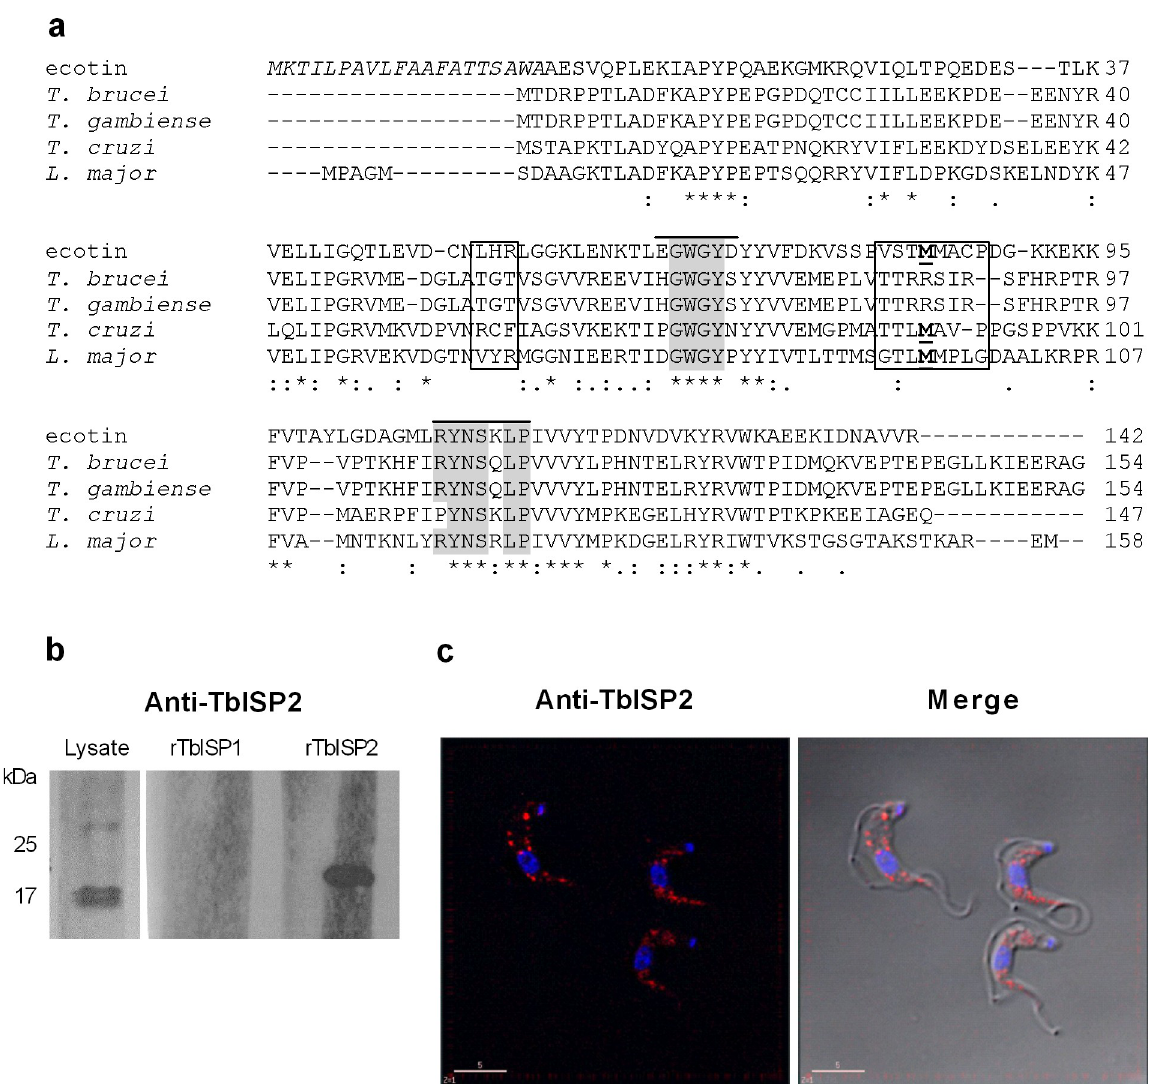
Fig 1. Expression of TbISP2 by T . b . rhodesiense bloodstream forms. (a) Alignment of predicted amino acid sequences of ecotin and ISP2. The numbering for ecotin indicates the mature protein, which starts at Ala1, and the signal peptide prior to this is given in italics. The primary enzyme recognition site (50s and 80s loops, respectively) deduced from ecotin-trypsin complex is marked in boxes and the reactive-P1 Met84 is bold and underlined. The box indicating the 80s loop of ecotin shows residues P4 to P4’ of the inhibitor’s reactive site [28]. Regions forming the secondary binding site (60s and 100s loops, respectively) in the ecotin-trypsin complex are indicated by a line at the top and the conserved residues in those regions are highlighted in grey. Ecotin: E . coli (K12) (UniProtKB—P23827 (ECOT_ECOLI), T . b . brucei (Tb927.5.1730), T . b . gambiense (Tbg972.5.2420), T . cruzi Dm28 (BCY84_00539-t36), L . major Friedlin (LmjF.15.0510). (b) Monoclonal antibodies against T . brucei ISP2 tested against T . b . rhodesiense whole cell lysate (lane 1), rTbISP1 100 ng (lane 2) and rTbISP2 100 ng (lane 3). (c) T . b . rhodesiense BSF parasites were harvested, washed in vPBS then fixed in 3% paraformaldehyde. Cells were then applied to poly-L-lysine-treated slides and permeabilized. Slides were blocked and subsequently incubated with anti-ISP2 antibodies. Anti-mouse Alexa Fluor 594 was used as secondary antibody and visualized on a rhodamine filter. Nuclear and kinetoplast DNA was stained with DAPI. Scale bar 5 μ m. purified against immobilized recombinant TbISP2 to determine the subcellular localization of TbISP2 in T . b . rhodesiense bloodstream forms by immunofluorescence (Fig 1C), in which a punctate cytoplasmic distribution for ISP2 was observed. To address the role of ISP2, we generated T . b . rhodesiense bloodstream form ISP2 -null mutant lines ( Δ isp2 ) by homologous recombination (Fig 2). Recombination cassettes